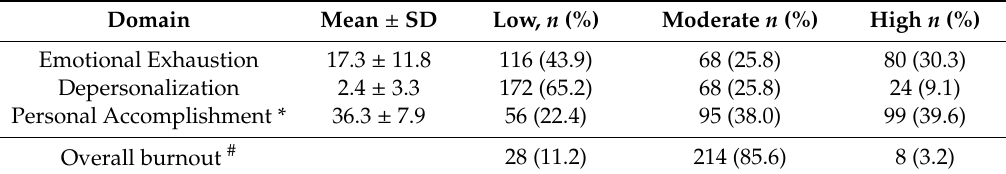
Table 3. Burnout syndrome among educators in University of Belgrade, East Sarajevo Kosovska Mitrovica.